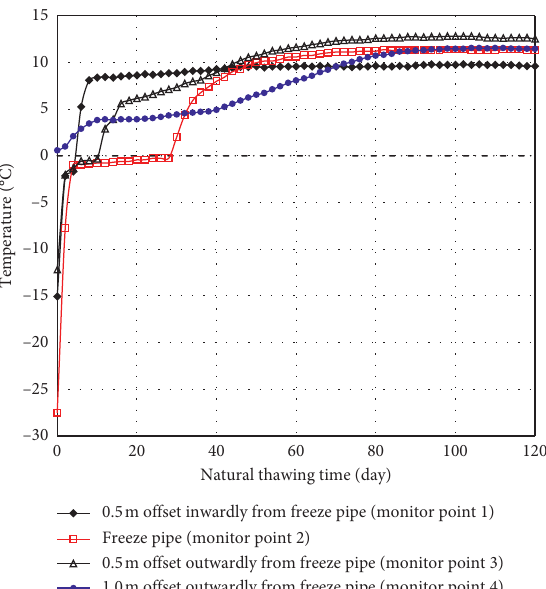
Figure 7: Variation of temperature with natural thawing time at monitor points 1 to 4 along Path 1.